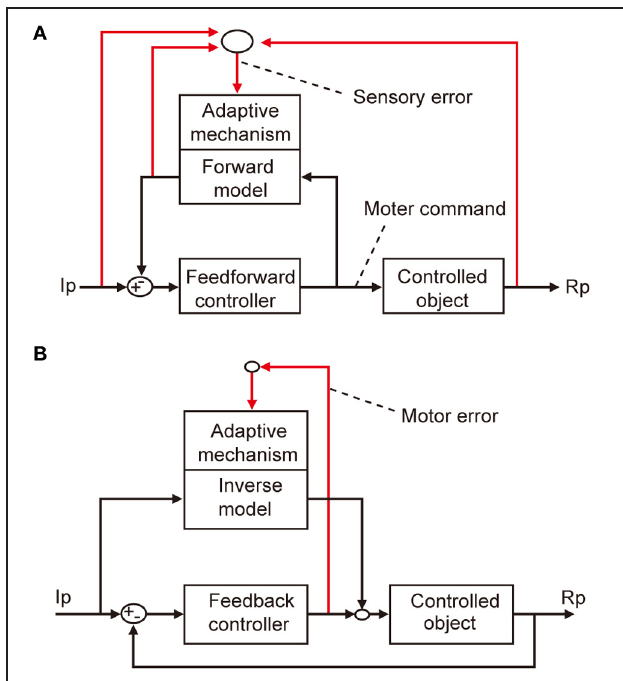
FIGURE 3 | Two types of internal model. (A) Forward model linked to feedforward controller. (B) Inverse model linked to feedback controller. VESTIBULOOCULAR REFLEX (VOR)